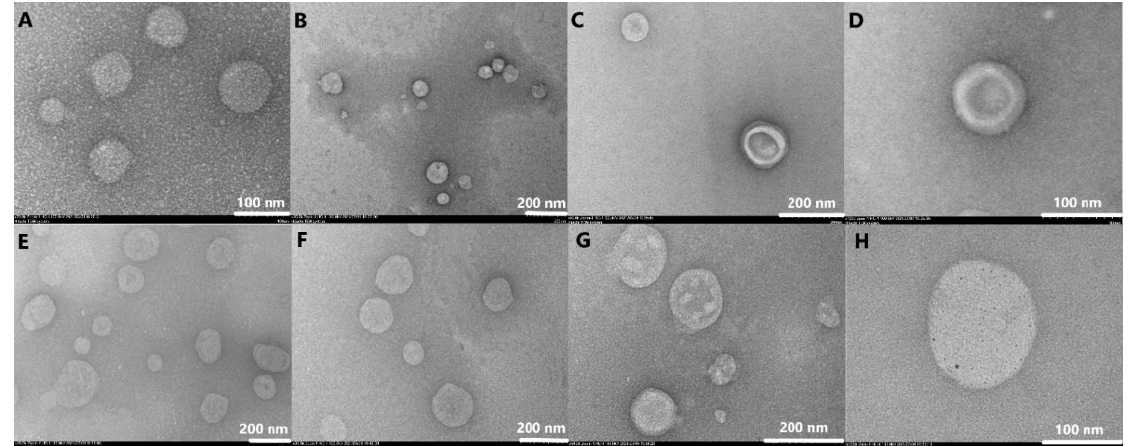
Figure 7. TEM images showing the morphology of N3 and N13 liposomal formulations. N3 before ( A , B ) and after ( C , D ) the incubation process. N13 before ( E , F ) and after ( G , H ) the incubation process. The images were taken at different resolutions for a better imaging. The scale bar is represented in the right bottom for each image.